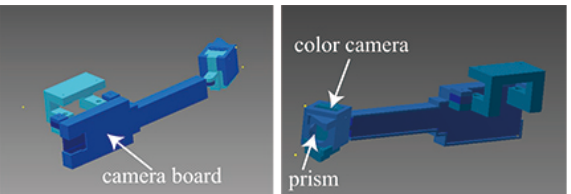
Figure 2 . Design of the third eye camera, which has four compo- nents, i.e., an eye camera, a prism, and a capture board.